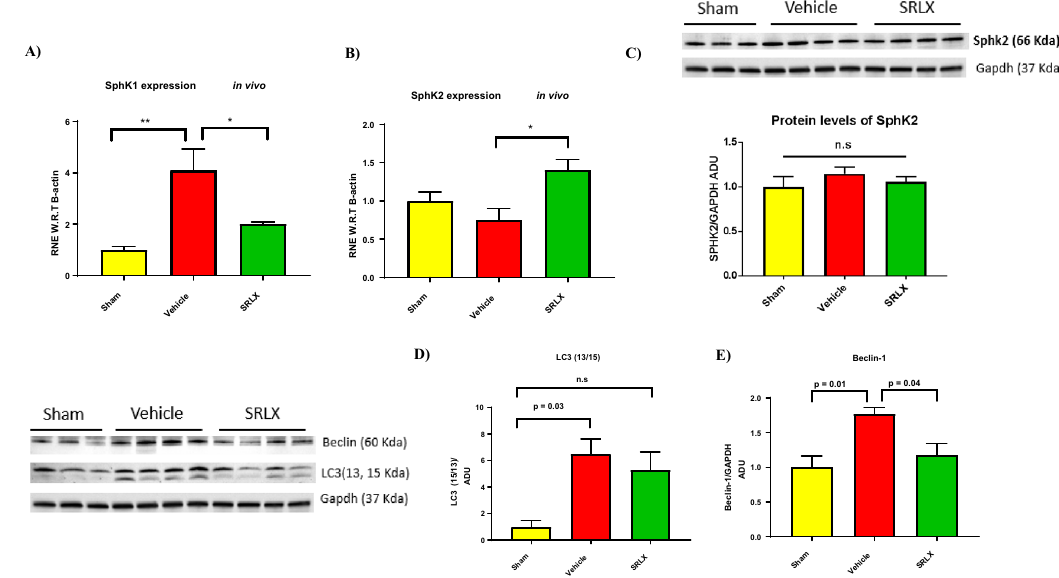
Figure 4. Expression of SphK1, SphK2 and autophagy markers in mice treated with serelaxin. ( A , B ) SphK1 gene expression is significantly lower in animals treated with serelaxin. Contrastingly, SphK2 gene expression is significantly higher in animals treated with serelaxin ( C ) SphK2 protein (70 kDa) levels are not significantly different between the vehicle treated and serelaxin treated groups For ( A – C ) (n = 4 for vehicle and SRLX groups), one-way ANOVA was utilized, followed by Tukey’s post hoc analysis. ( D ) The expression of the cleaved, active form of LC3 (13 KDa) is significantly higher in the vehicle group (when compared to sham mice). Contrastingly, no significant difference in LC3-13/15 ratio was observed between the sham and serelaxin treated groups; ( E ) The expression of the autophagy marker Beclin-1 (60 kDa) is significantly lower in mice treated with serelaxin 28 days post MI. For ( D , E ) n = 4 for vehicle and SRLX groups and n = 3 for sham group. One-way ANOVA with Tukey’s post-hoc analysis was utilized. Western blots for figures ( C ) and ( D ) were obtained from the same gel blot, and utilize the same GAPDH band (37 kDa) as can be seen in ( C ) and ( D